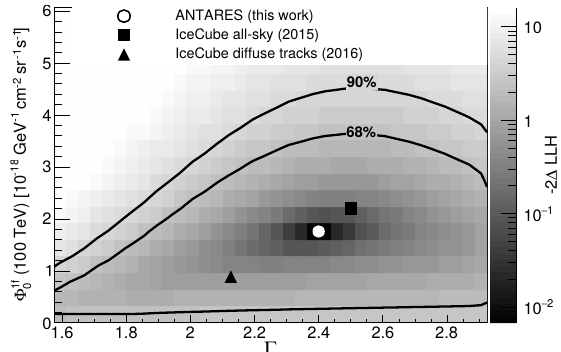
Figure 4. ANTARES 2D log-likelihood scan of the di ff use cos- mic fl ux normalization and spectral index from [15]. Empty cir- cle is the fl ux fi t, showing also IceCube di ff use all-sky [16] and track [7, 8] analysis results and the 68% and 90% con fi dence con- tours. A 85% contour would start to exclude the null hypothesis.